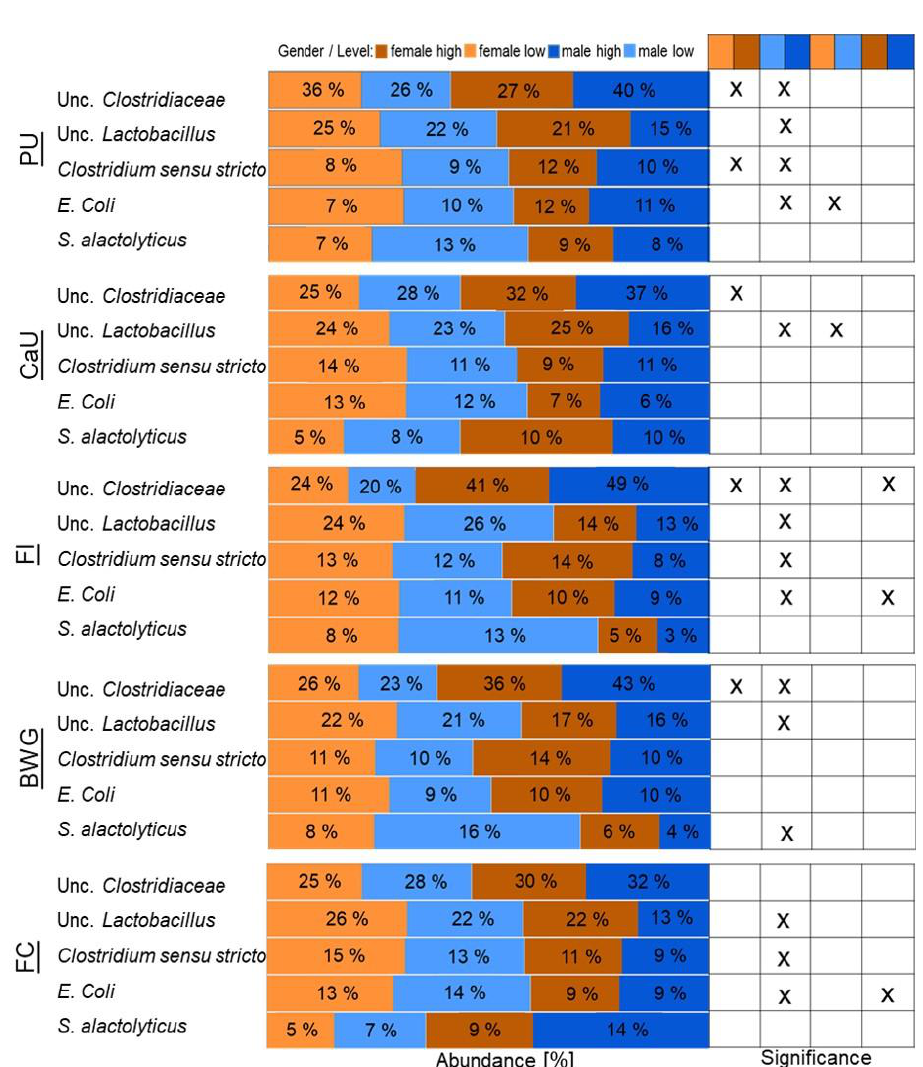
Clostridia are common colonizers of broiler and quail GIT [46] and are responsible for plant material